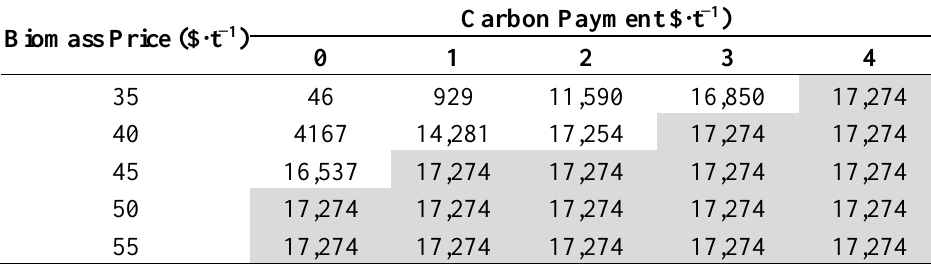
Table 5. Combined effects of biomass price and carbon offset payments on the amount of economically feasible area (ha) with property tax